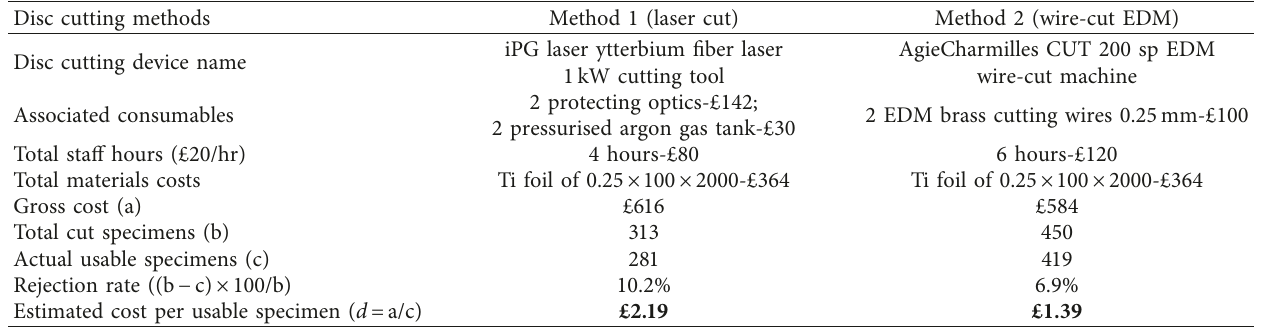
Table 1: Cost analysis of the disc cutting methods. Titanium foils (thickness 0.25mm; purity 99.5%; 100 × 2000mm; Alfa Aesar) were used. Staff rate of £20 per hour was considered as a typical wage for technical staff members trained to graduate level in the UK (prices current June 2018).